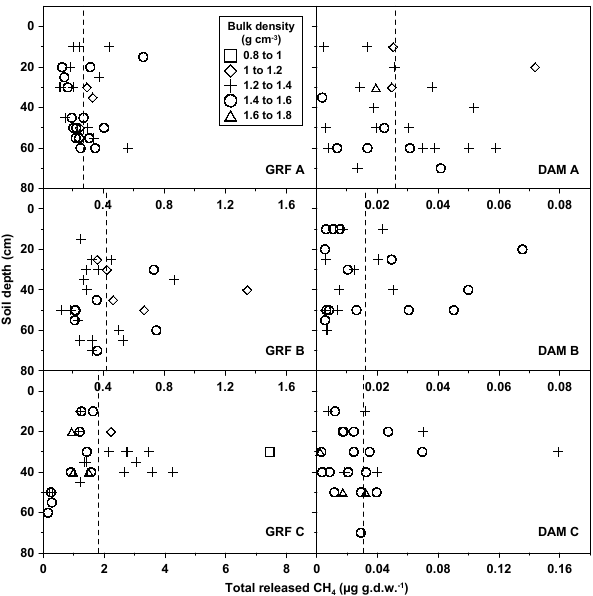
Fig. 3. Depth distribution and cumulative CH 4 released from in- dividual miniature soil cores. The different symbols denote bulk- density classes of individual cores. Vertical dashed lines indicate the average cumulative CH 4 release for each